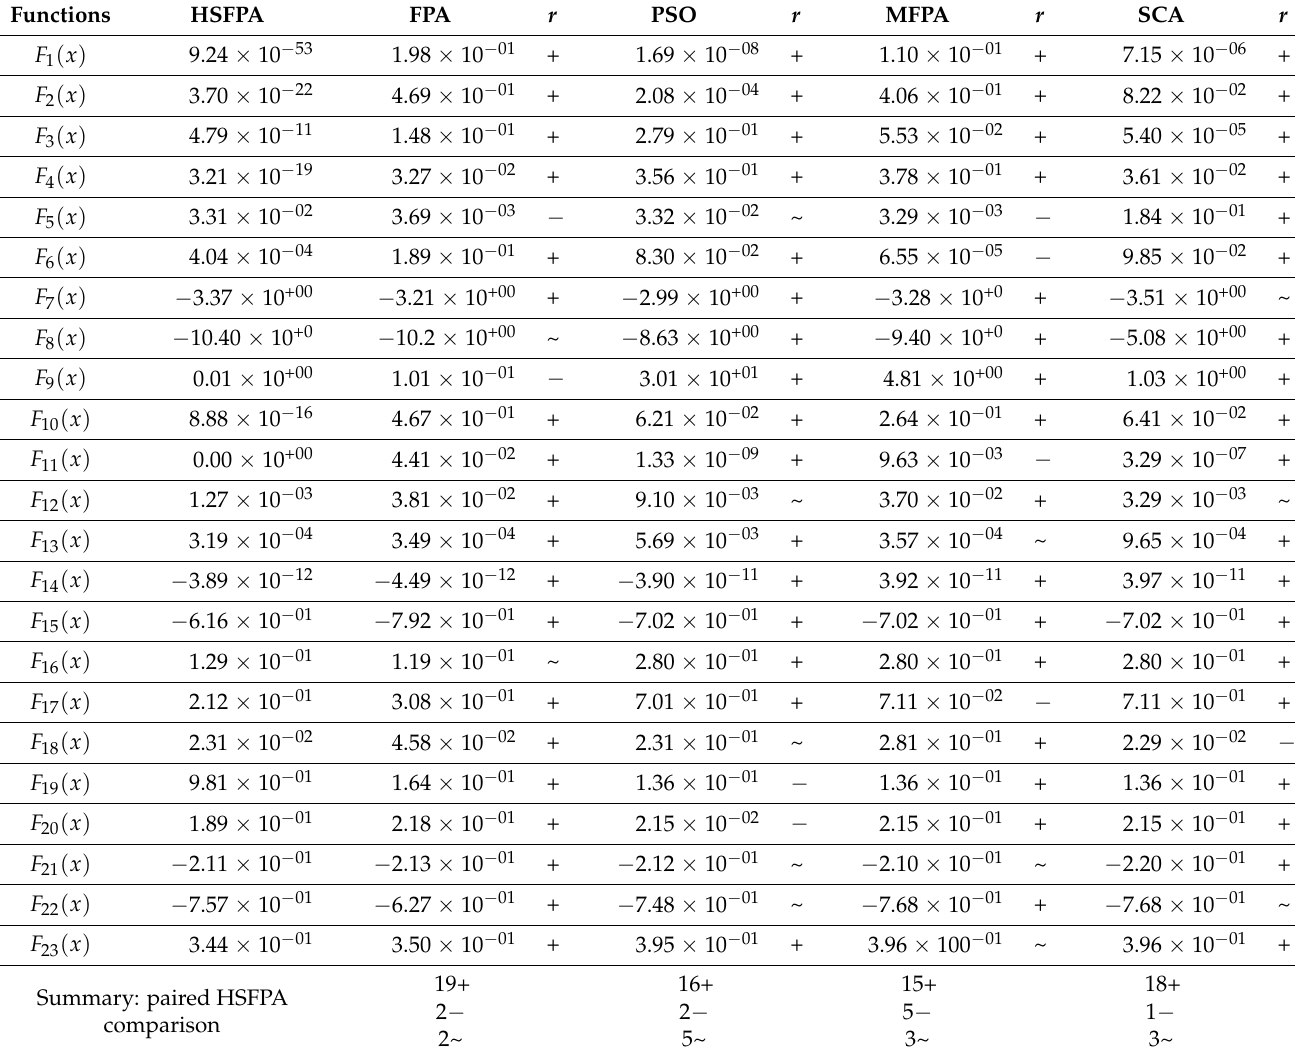
Table 2. Comparison of the HSFPA for 23 selected testing functions with the FPA, PSO, MFPA, and SCA algorithms,